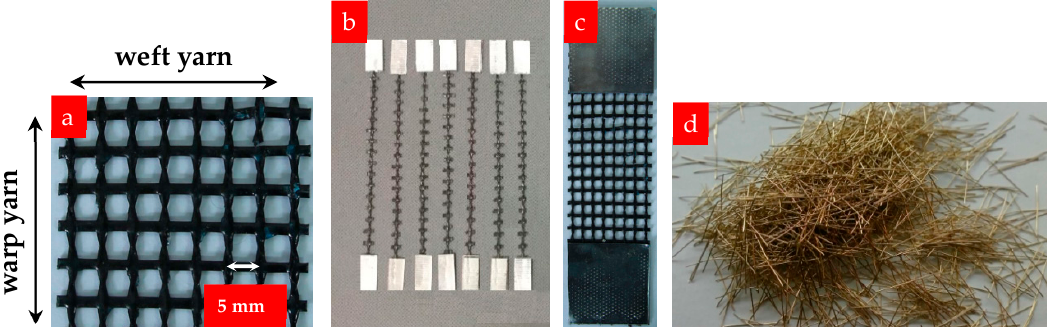
Figure 1. ( a ) Carbon textile impregnated with resin epoxy, ( b ) single yarn samples, ( c ) strip sample, and ( d ) steel fibers.